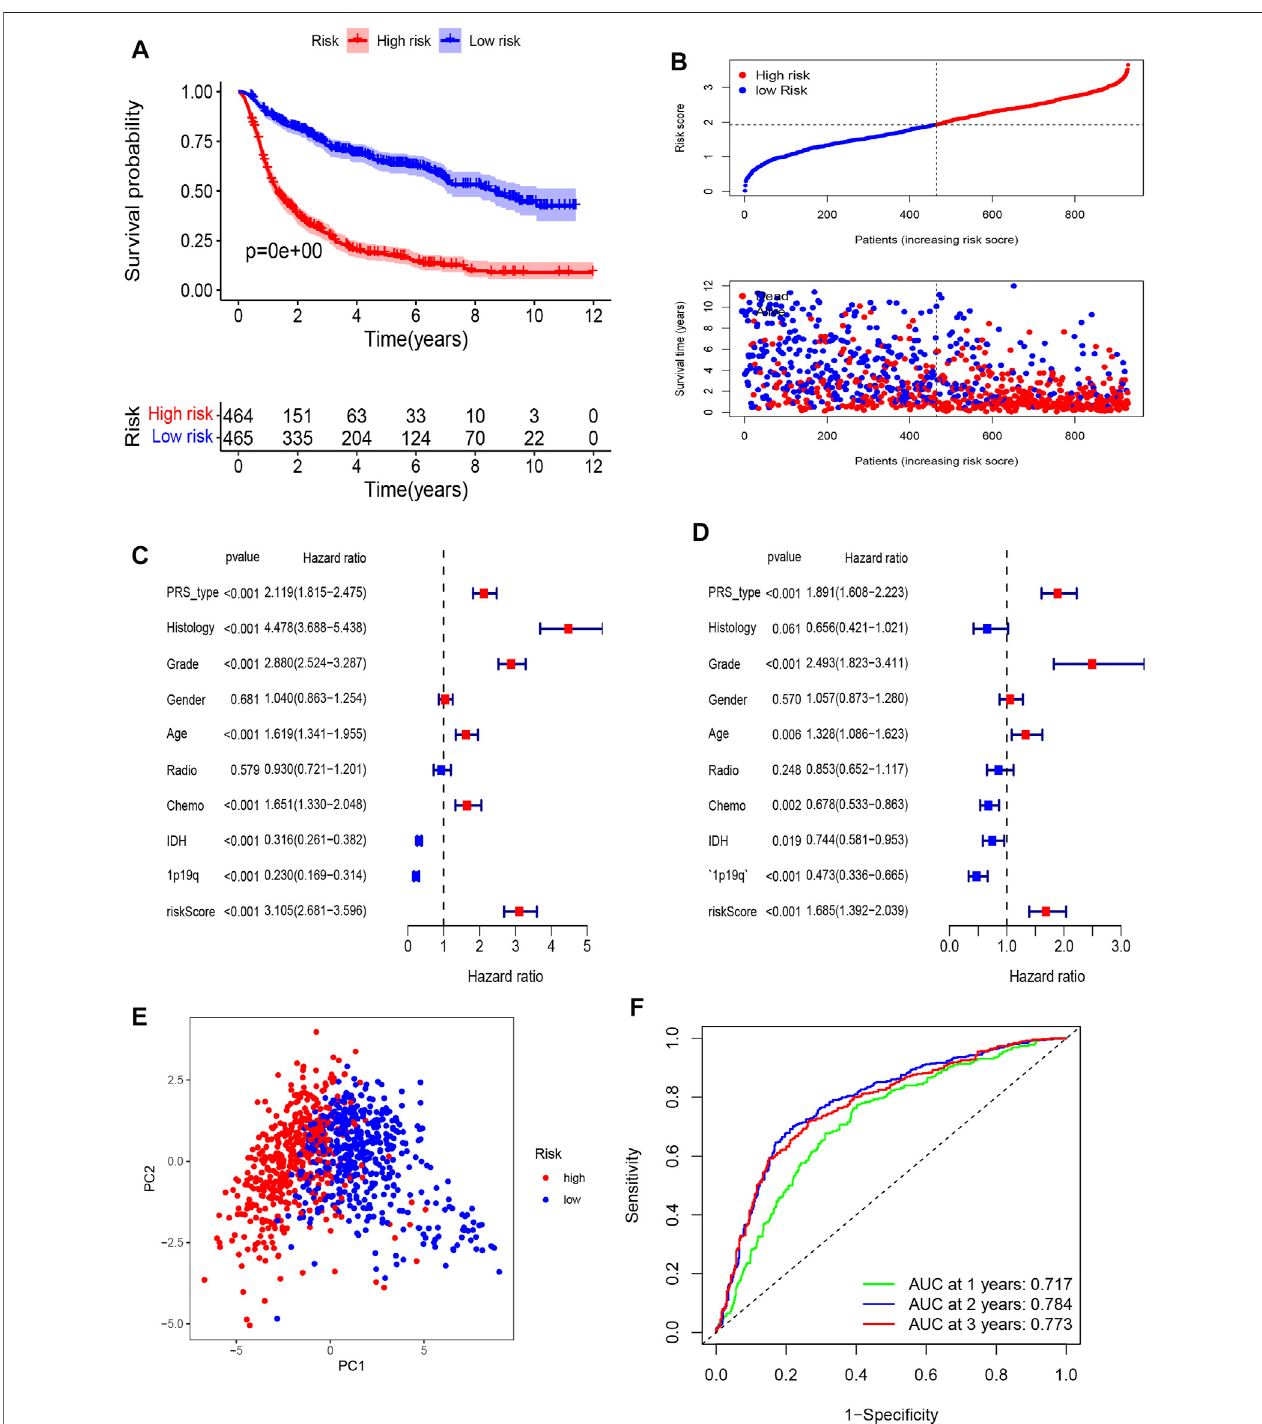
FIGURE 3 | Establishment of a pyroptosis-related gene prognostic signature in the CGGA cohort. (A) Kaplan-Meier curves for OS of patients in high- and low-risk group in CGGA Cohort. (B) Distribution of risk score of all patients of CGGA cohort, and Patients ’ survival time distribution. (C) Forest plot of univariate cox regression betweenriskscoreandprognosisofglioma. (D) Forestplotofmultivariatecoxregressionofbetweenriskscoreandprognosisofglioma. (E) PCAplotforsignaturegenes based on risk score group. (F) ROC curves showed the predictive ef fi ciency of risk score at 1-year, 2-years, 3-years point.